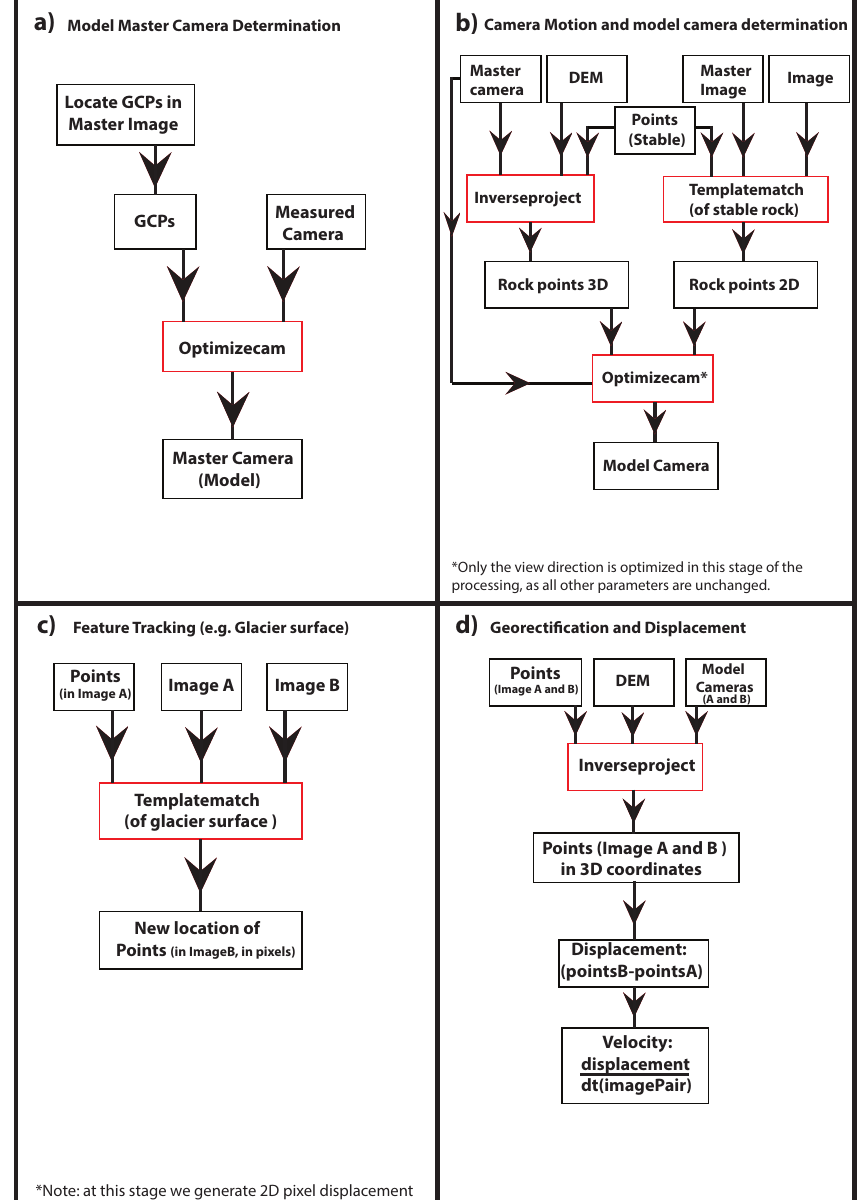
Figure 3. A schematic overview of the key steps in the ImGRAFT processing chain. Boxes outlined in red indicate functions and those in black indicate inputs or